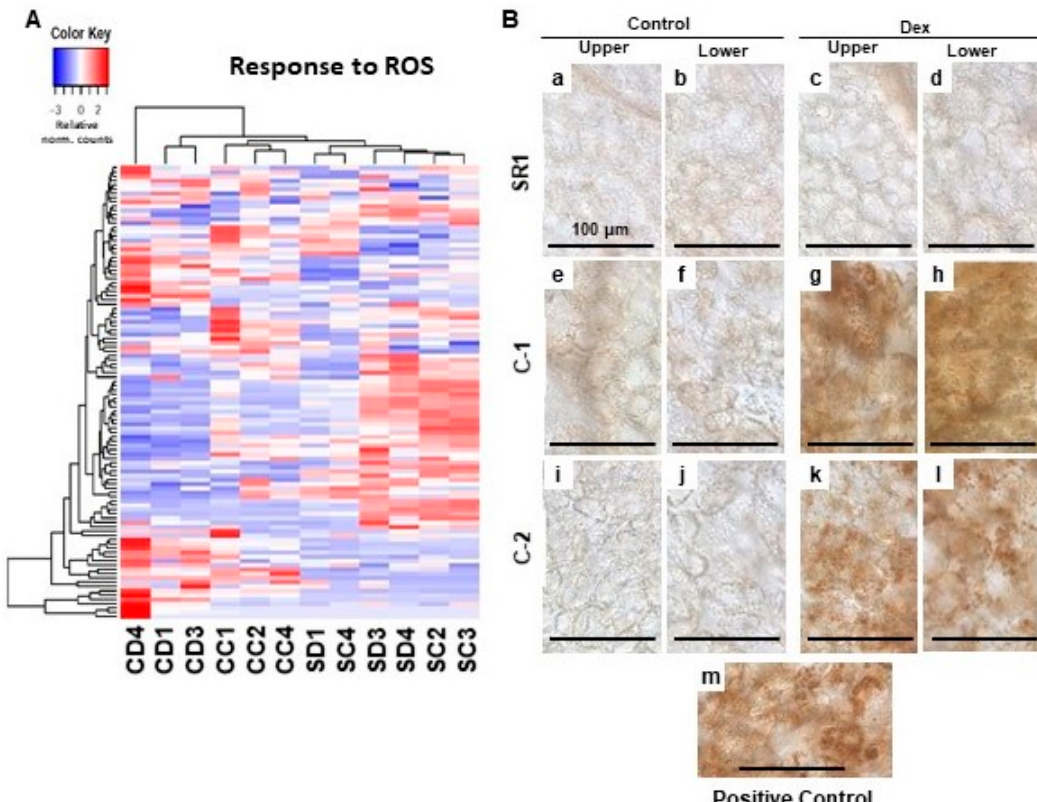
Figure 4. Hierarchical clustering of oxidative stress-responsive genes and detection of the H 2 O 2 production in the chloroplasts of leaves developing chlorosis. ( A ) The genes annotated with the GO term response to oxidative stress (GO:0006979) were selected, and their relative-normalized count data were used to draw a heatmap. Each column represents a sample, and each row represents a gene selected. Differences in the expression are shown in different colors; red and blue represent the up- and down-regulated expression, respectively. ( B ) Control plants (SR1; a–d), i-amiCHLI transgenic line 1 (C-1; e–h), and line 2 (C-2; i–l) plants were grown, treated with control or Dex solution. At 24 h post-treatment, leaf disks of 6 mm in diameter were cut out from upper and lower leaves, vacuum-infiltrated with DAB solution, and incubated under light conditions (70–100 µ molem − 2 s − 1 for 30 min). Untreated SR1 plants illuminated with 250–300 µ molem − 2 s − 1 for 60 min served as a positive control (m). All leaf disks were incubated under dark for 3.5 h, de-colorized, and observed under a